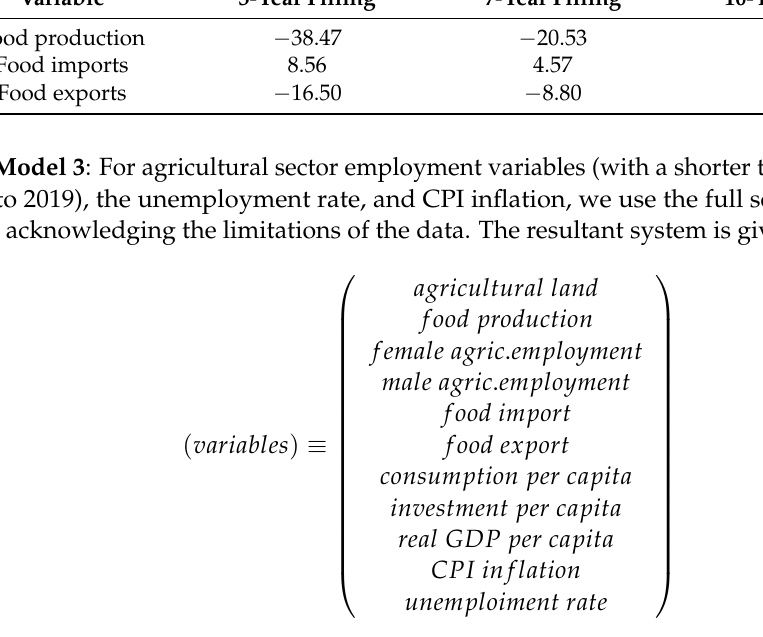
Table A3. Average annual losses/gains (%) in food production, food imports, food exports, and CPI inflation relative to the baseline scenario based on VECM estimates.